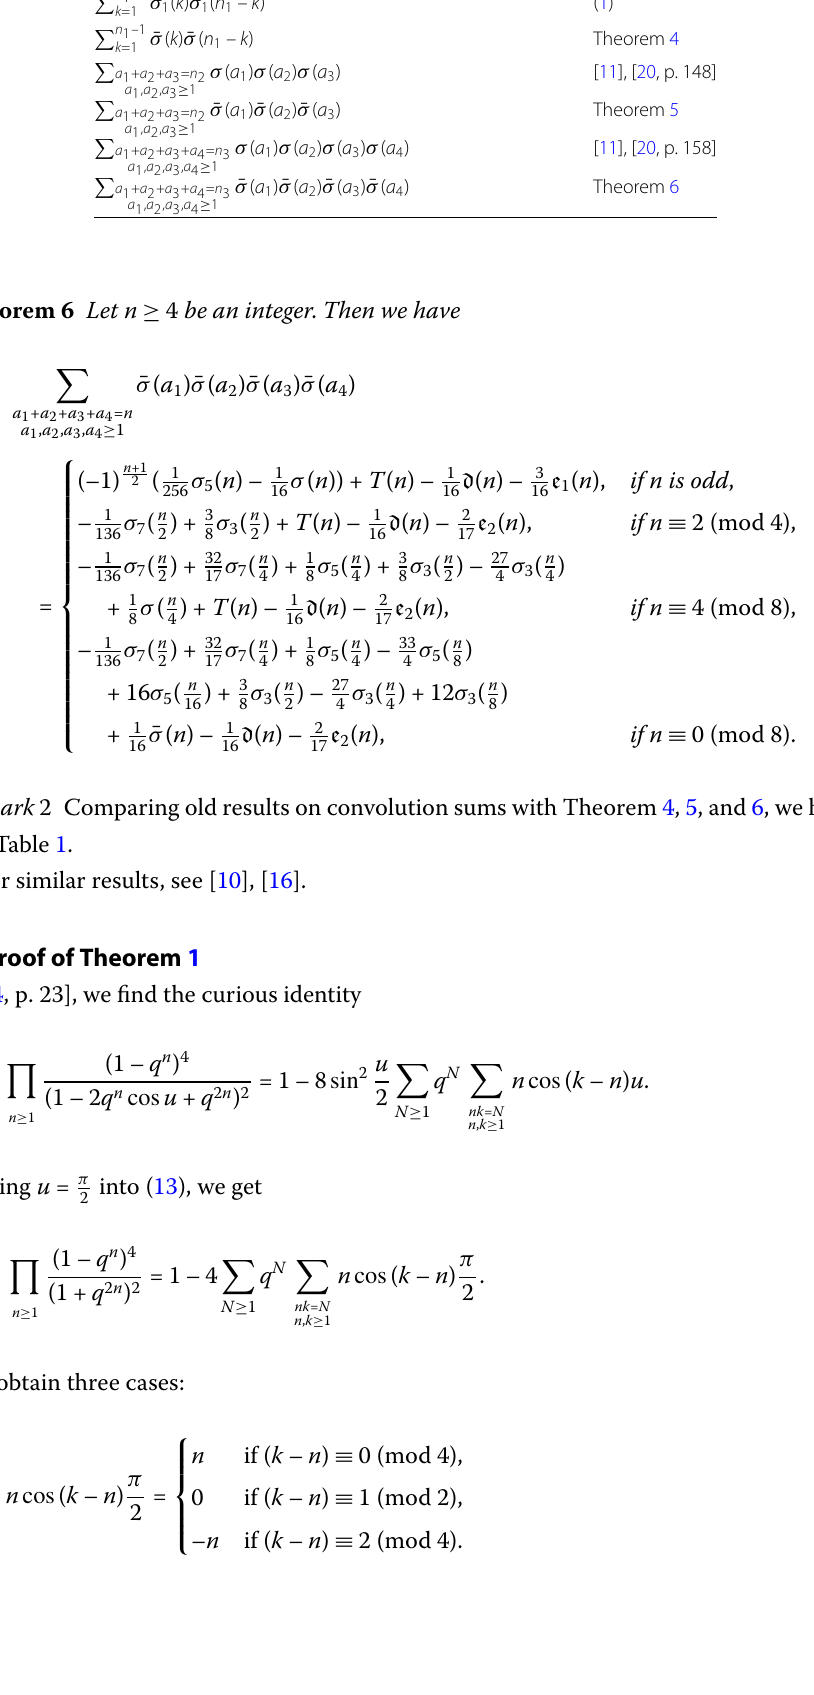
Table 1 Identities of convolution sums Identities of convolution sums Reference (cid:14) n